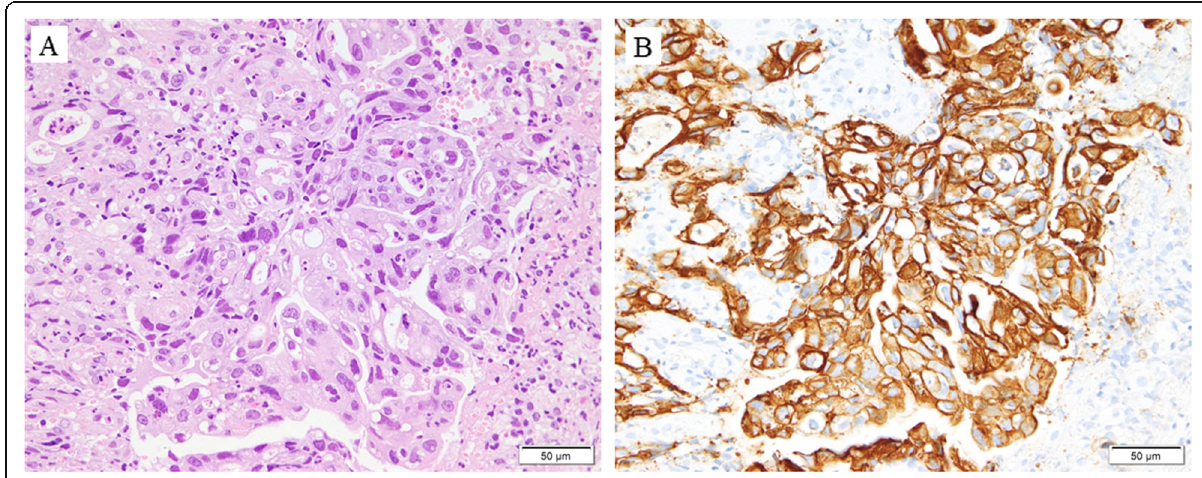
Fig. 2 a Hematoxylin and eosin staining in the biopsy specimen confirming poorly differentiated adenocarcinoma. b HER2 immunohistochemical staining in the biopsy specimen confirming strong expression of HER2 in the tumor cell